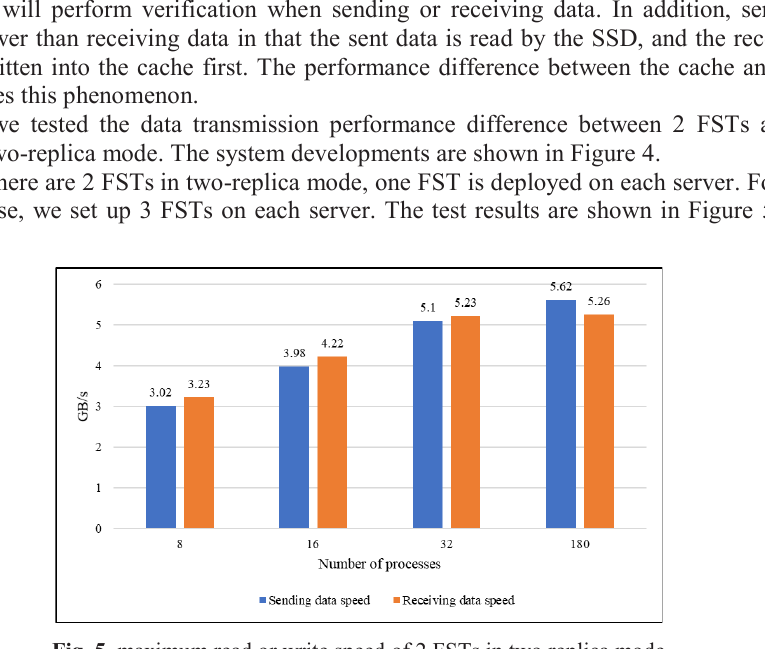
Fig. 5. maximum read or write speed of 2 FSTs in two replica mode